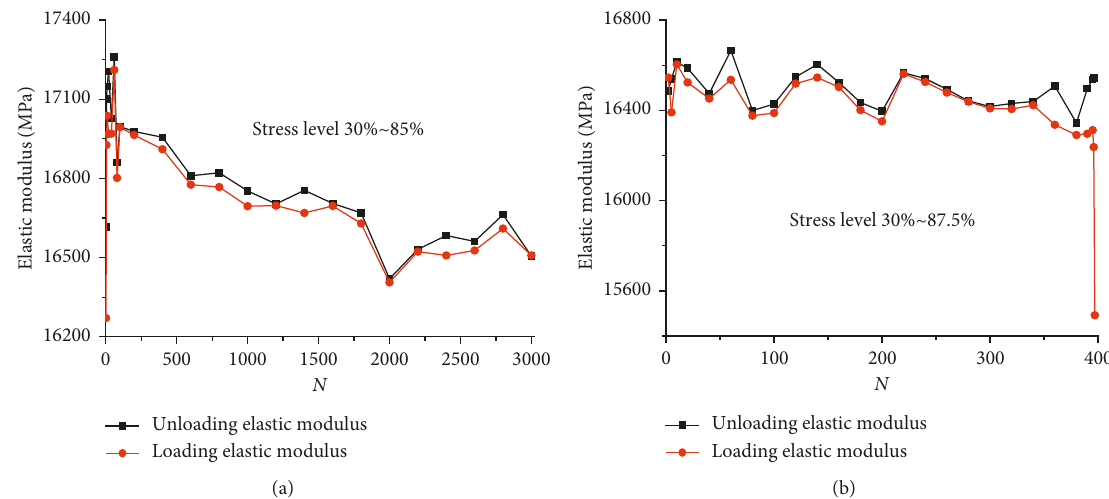
Figure 9: Elastic modulus versus cycle number curves of limestone sample SA. 6 at different amplitudes of cyclic loading during the (a) first stress level and (b) second stress